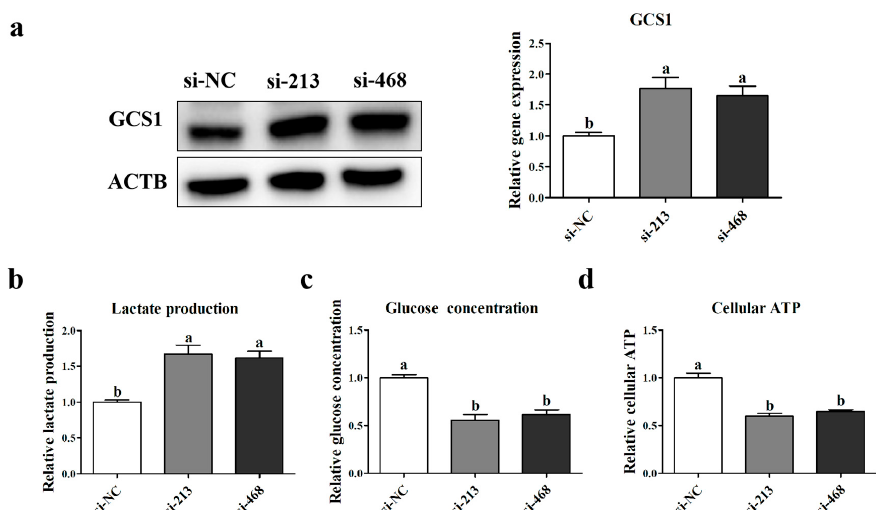
Figure 8. The expression of GCS1 protein was detected using Western blot ( a ). Lactate and glucose concentrations in the cell media ( b , c ) and cellular ATP ( d ) were determined using an ELISA assay ( a ). Expression of the protein was normalized to β -actin ( ACTB ) and related to si-NC. Results are expressed relative to the si-NC as mean values ± SEM ( n = 3). a, b, c: different letters denote statistically significant differences within each group; p < 0.05.